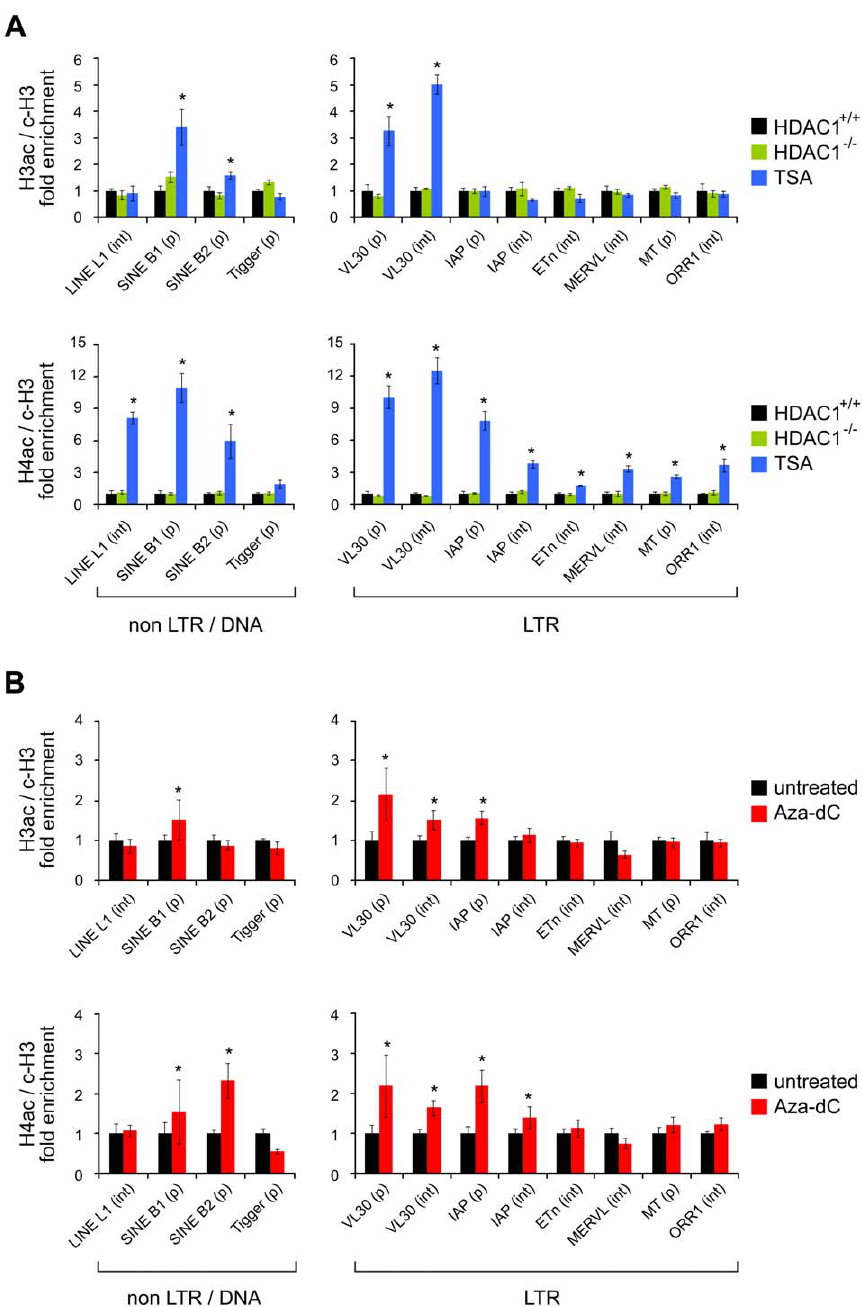
Figure 2. Histone acetylation states of transposable elements upon HDAC1 depletion, TSA treatment, and Aza-dC treatment. The histone acetylation state of chromatin associated with defined transposable elements was determined via ChIP technique using antibodies specifically recognising acetylated histone H3 (H3ac) and acetylated histone H4 (H4ac). Values were normalised to the nucleosome density as determined via ChIP using antibodies recognising the C-terminal region of histone H3 (c-H3) and are given relative to the acetylation levels in untreated fibroblasts. Control experiments employing unspecific IgG antibodies consistently led to negligible amounts of precipitated material (data not shown). (A) Histone H3 and H4 acetylation levels of a variety of transposable elements in HDAC1 2 / 2 (green bars) and TSA (166nM; 24h; blue bars) treated fibroblasts as compared to untreated HDAC1 + / + (black bars) fibroblasts. (p) promoter region 6 500bp of transcriptional start site; (int) internal region. N=3; 6 SEM *p , 0.05 (paired, one sided student’s t-test). (B) Corresponding acetylation levels of transposable elements in Azd-dC treated fibroblasts (1 m M; 24h, 24h recovery; red bars). N=5; 6 SEM *p , 0.05. doi:10.1371/journal.pgen.1000927.g002 transposons, and murine and human L1 elements in untreated and episomally delivered retrotransposons are marked with a neo- TSA treated cells. In order to avoid potential interference with transgene, which gets activated only after its successful retrotrans- endogenously transcribed IAP, MusD and L1 elements, we position (Figure S2A). Following this approach we quantified the performed the experiments in the human U2OS osteosarcoma transposition efficiency of murine IAP and MusD LTR retro-